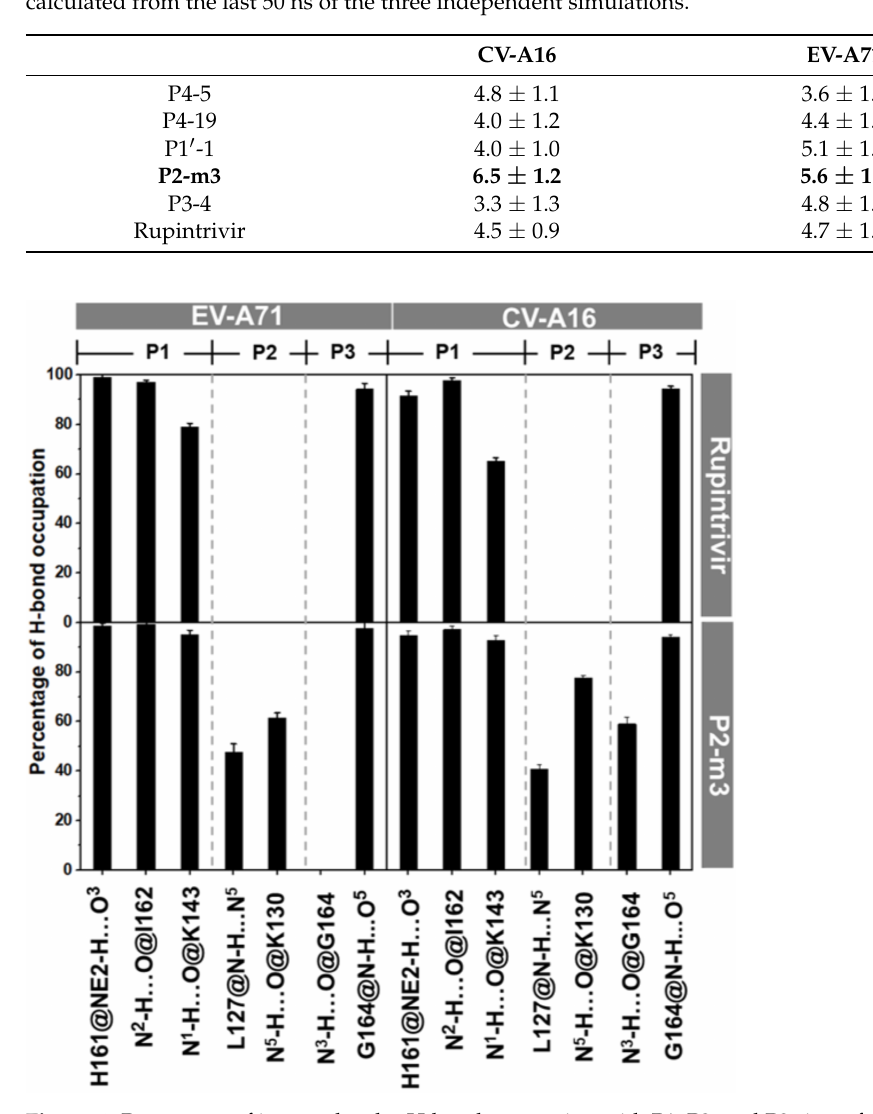
Figure 4. Percentage of intermolecular H-bond occupation with P1, P2, and P3 sites of the rupintrivir and its analog P2-m3 with EV-A71 and CV-A16 3Cpro derived from the last 50 ns simulations, where the representative structures are depicted in Figure 5. Only H-bond occupation > 40% is shown in the